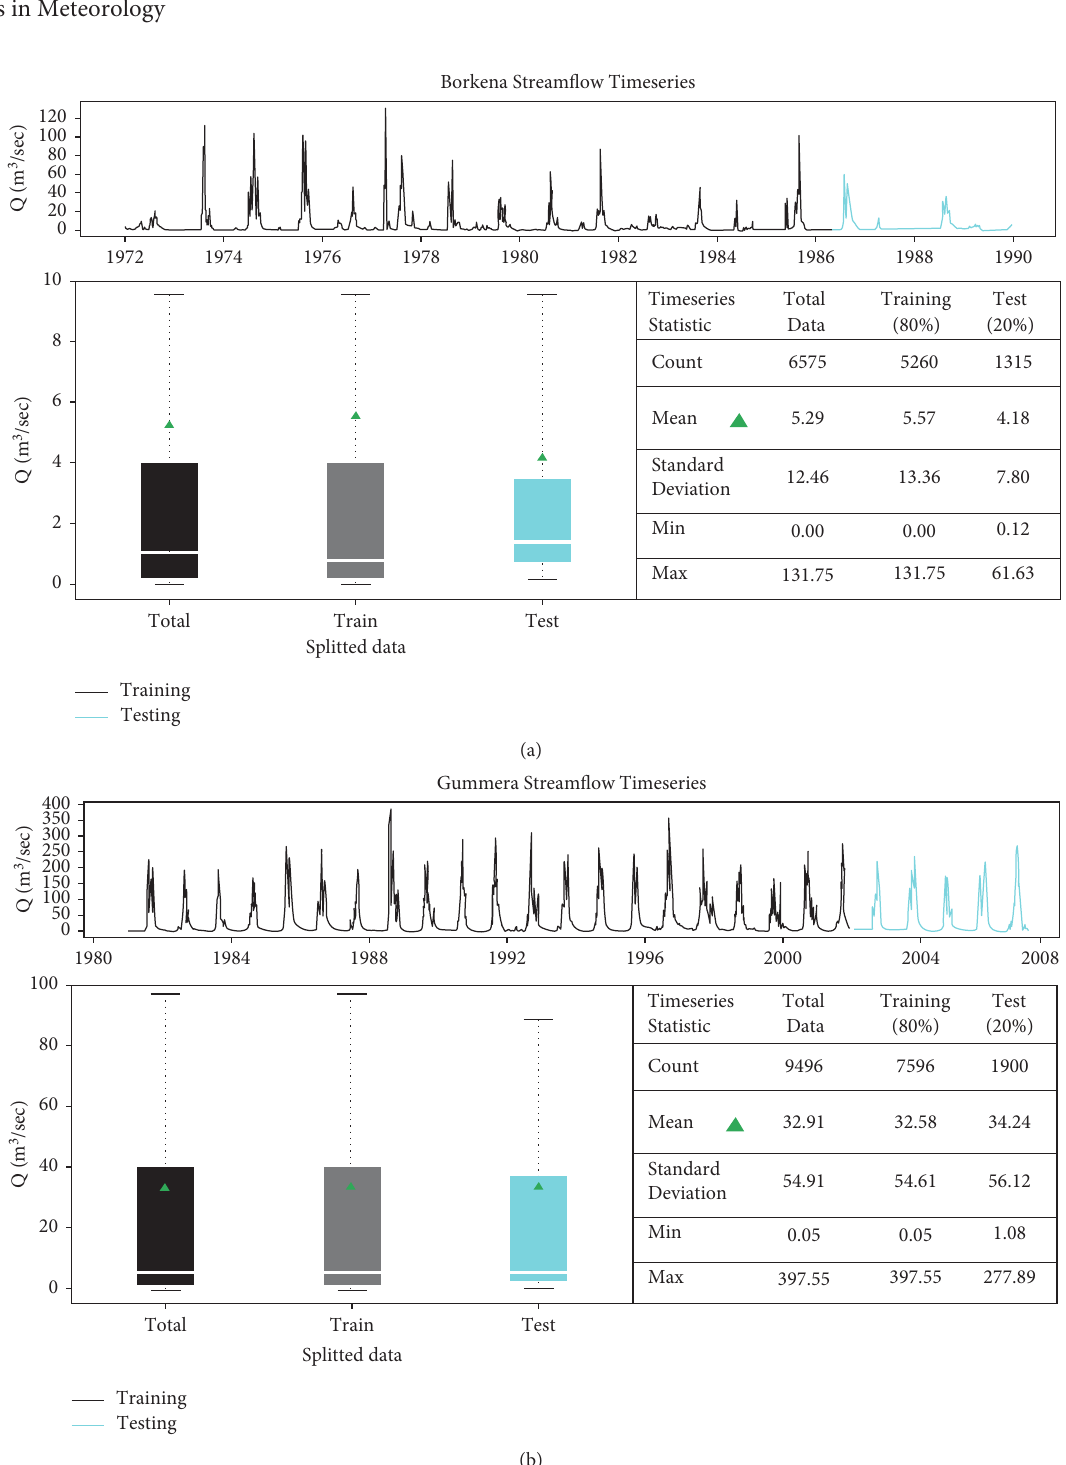
Figure 2: Descriptive statistics and the corresponding box plots of split data. (a) Borkena station, (b) Gummera hidden layers [44]. Three-layered MLP is common in hy- drological time series modelling. Figure 3. Conditional to the layer location, the series of inputs form an input vector X � ( x , x , . . . , x ). The equivalent series 1 i n of weights fit to each input form a weight vector